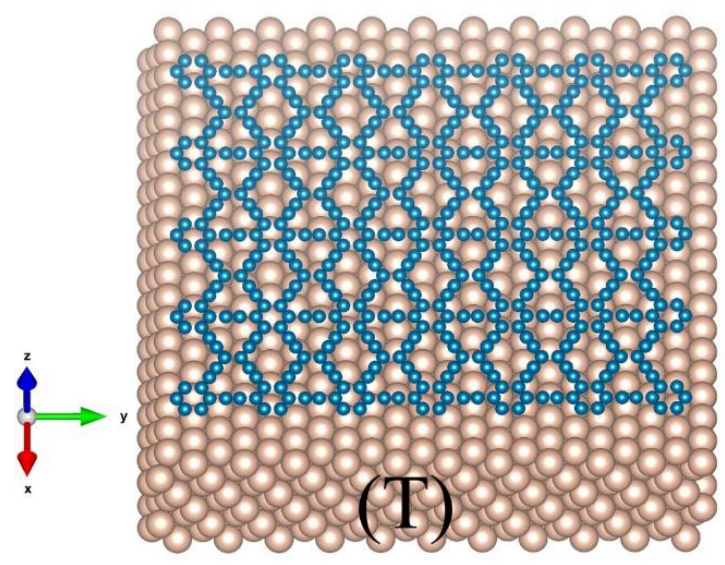
Figure 1. Schematic of a piece of 2D material of N atoms (blue color) lying on the surface of a substrate of M atoms (golden color) at temperature T .